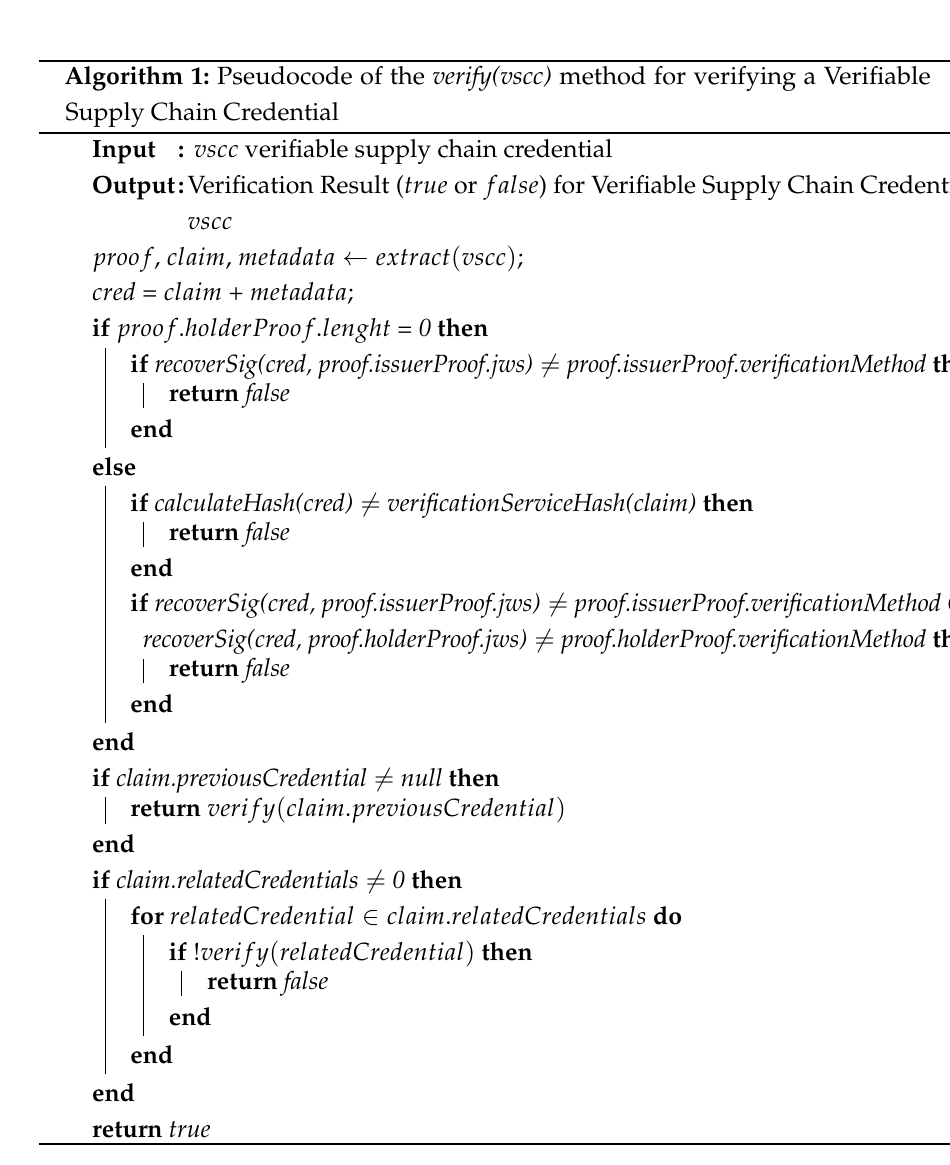
Algorithm 1: Pseudocode of the verify(vscc) method for verifying a Verifiable Supply Chain